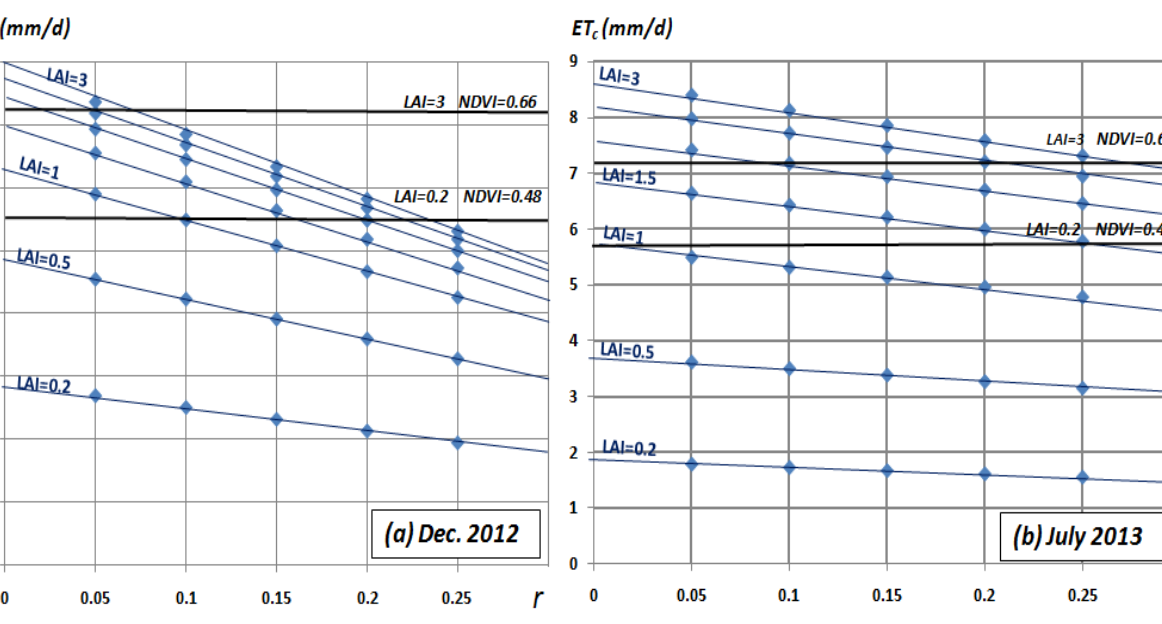
Figure 11. Relationship between crop evapotranspiration ET estimated with the analytical c approach (blue) as function of surface albedo r for different values of LAI and crop height h = 0.4 m; values of ET calculated with K -NDVI approach (black) for two values of c c c NDVI , NDVI calculated with Equation (20) for the values LAI , LAI shown in min max min max this figure; ( a ) December 2012 and ( b ) June